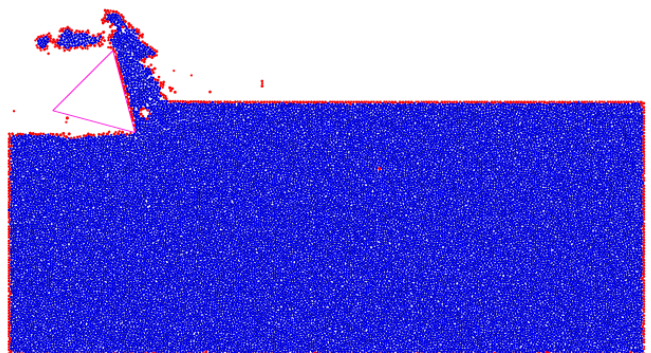
Figure 8. Boundary particles recognized in cutting process.